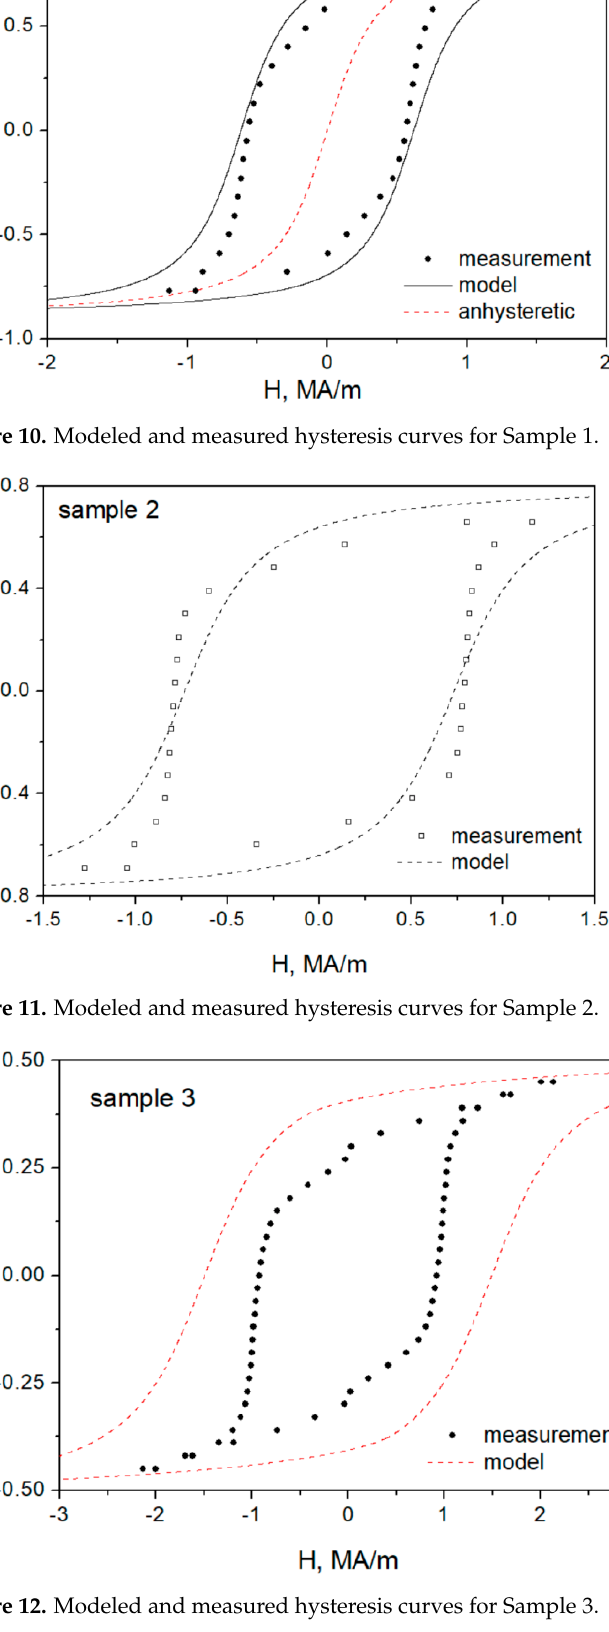
Figure 12. Modeled and measured hysteresis curves for Sample 3.